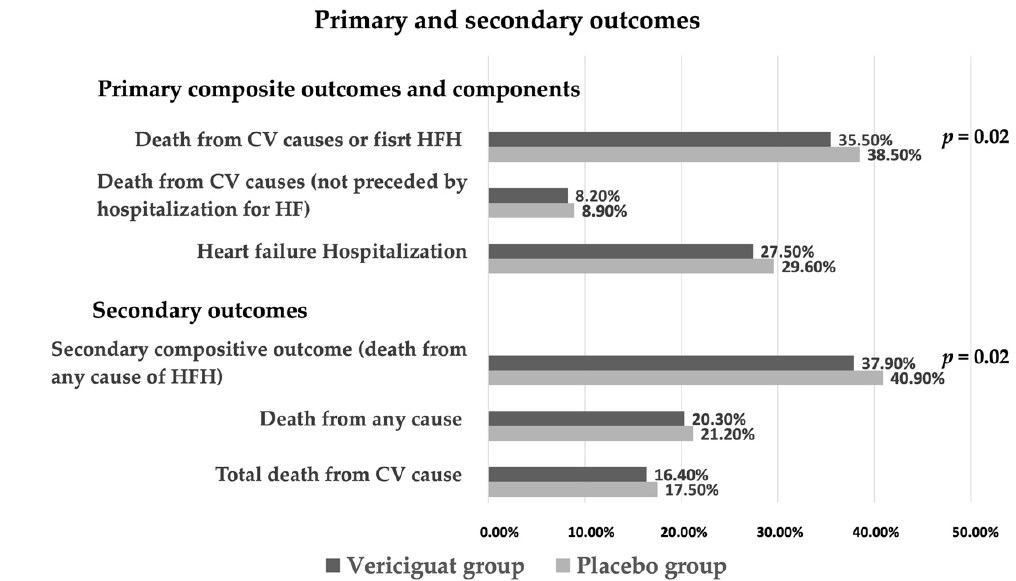
Figure 2. Incidence of primary and secondary outcomes in VICTORIA trial. CV = cardiovascular; HF = heart failure; HFH = heart failure